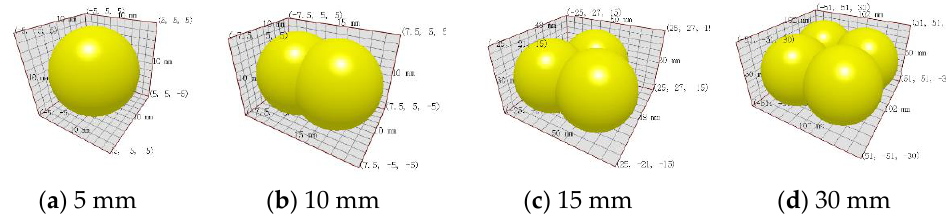
Figure 3. Soil particles with different sizes.